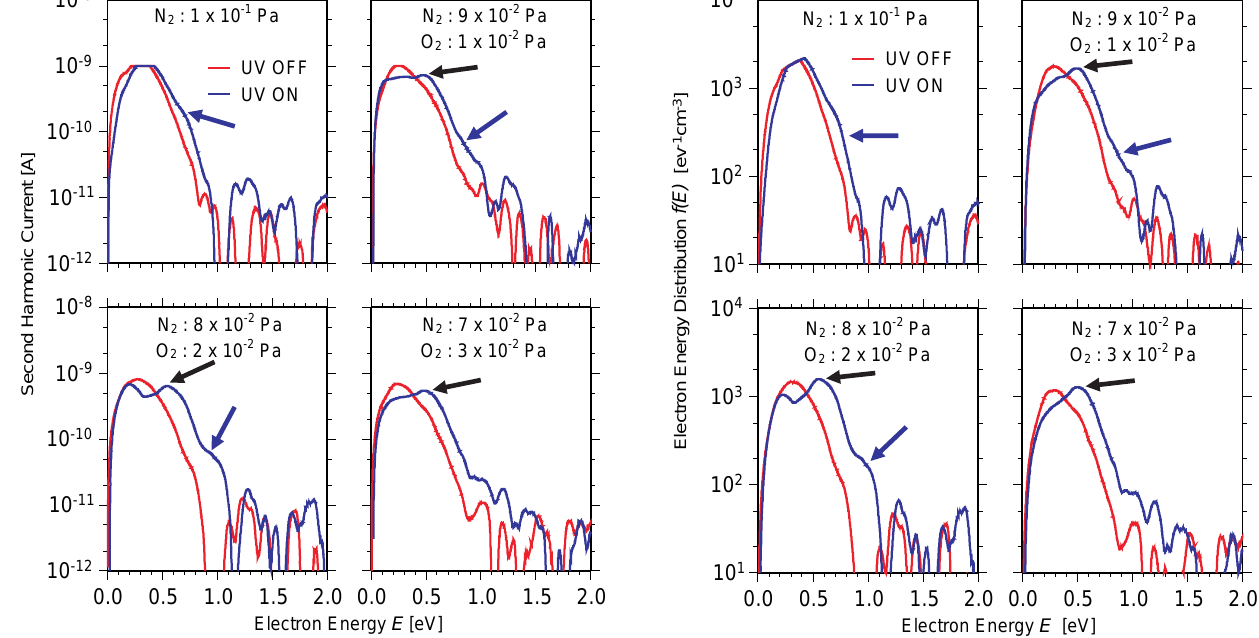
Fig. 5b. The same as for Fig. 5a, but the vertical axis is expressed as electron energy distribution functions, that is calculated according to the Eq.